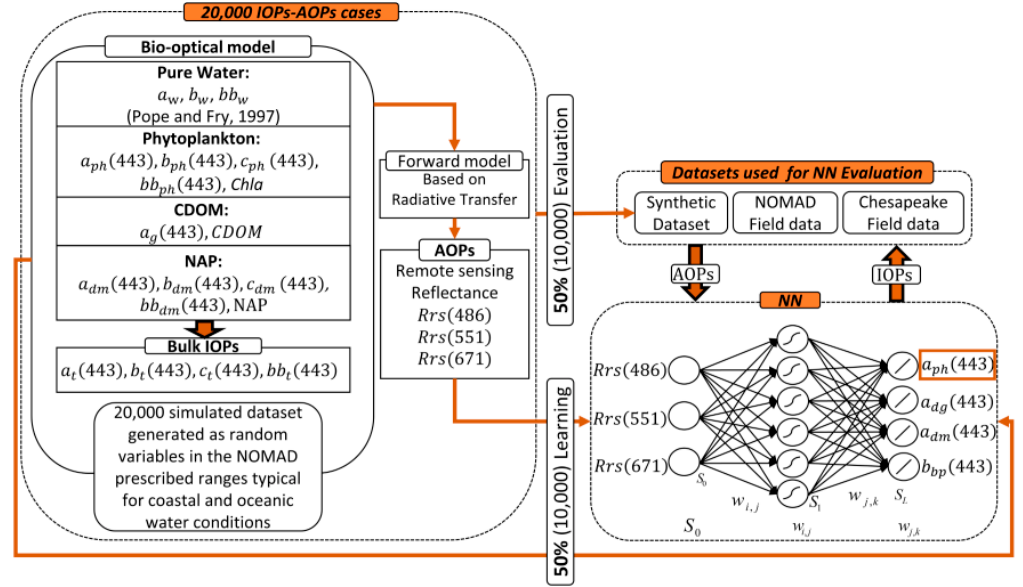
Figure 1. ( a ) Flowchart of Bio-Optical model and the Forward Model simulations; ( b ) Architecture of VIIRS NN, one-hidden layer multilayer perceptron (MLP), trained with 10,000 set of Rrs and related